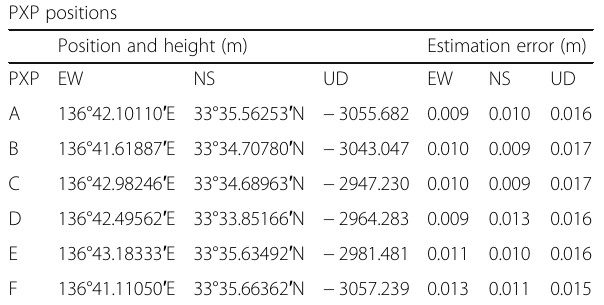
Table 1 Results of individual PXP positioning PXP positions Position and height (m) Estimation error